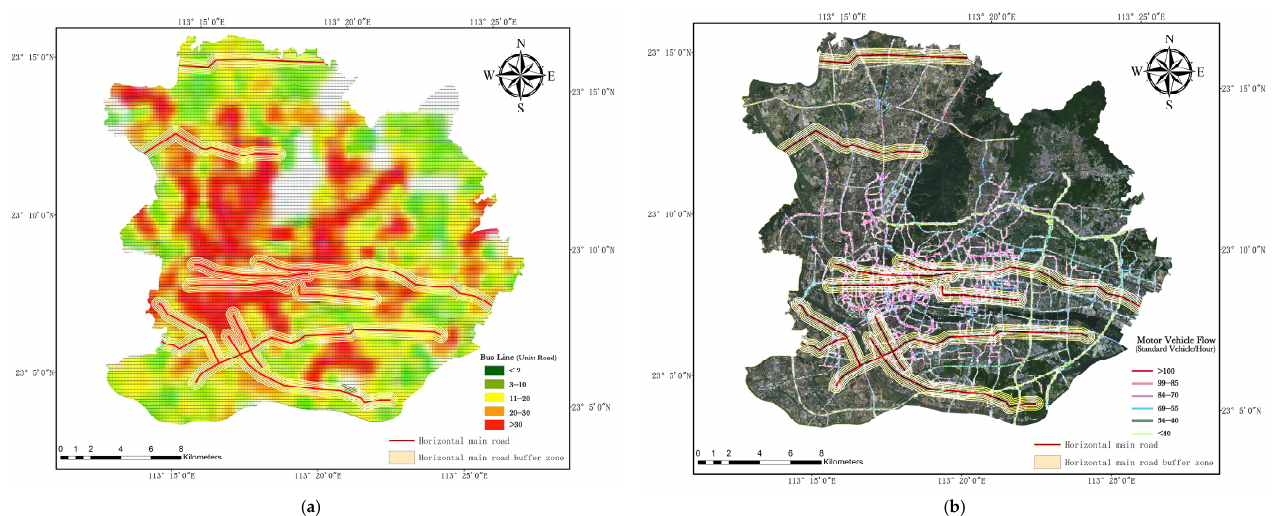
Figure 7. Analysis of the mechanism of horizontal trunk road corridor effect: ( a ) bus network density; ( b ) traffic